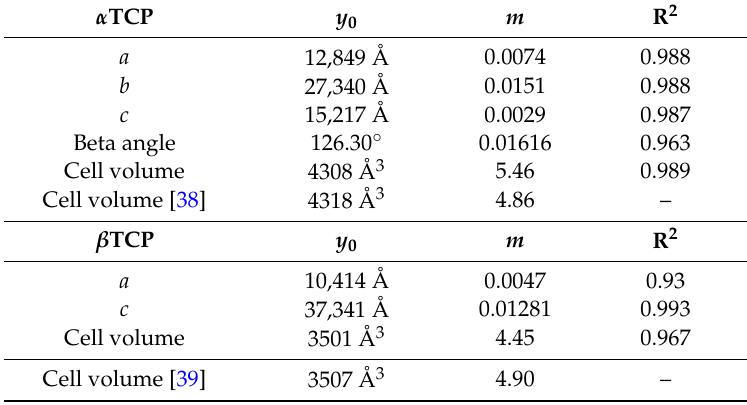
Table 2. Linear dependence of lattice parameters and volume vs. Strontium content: y = y 0 + m · x Sr . y 0 refers to Sr-free composition, x sr : strontium content (%), m: extent of variation with the strontium